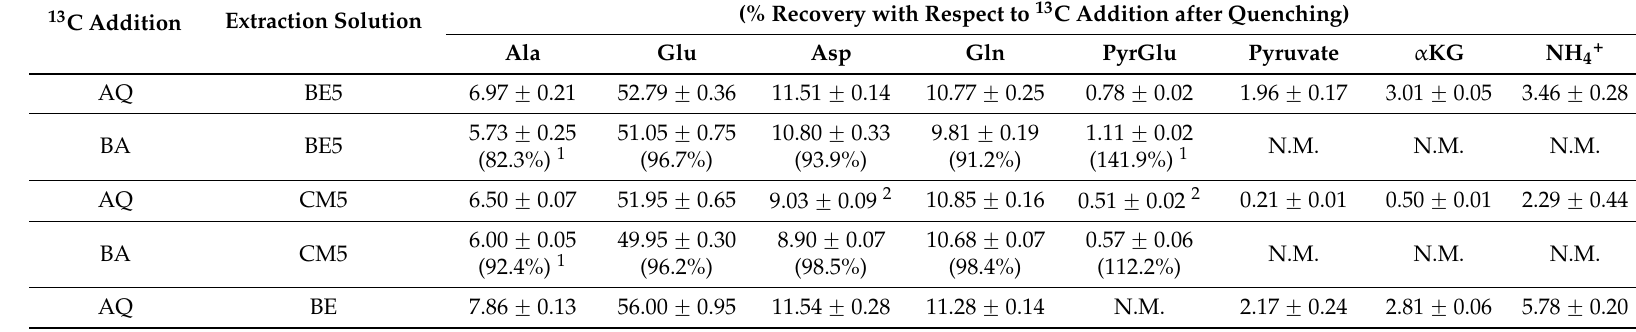
Table 3. Quantitative analysis of amino acid decay using different extraction methods. The results displayed are averages of three independent samples (in µ